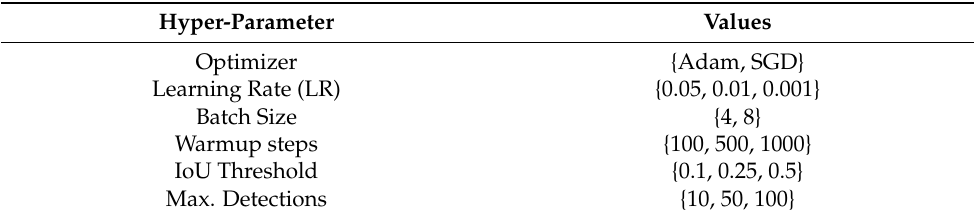
Table 2. Hyper-parameters evaluated for each detector.